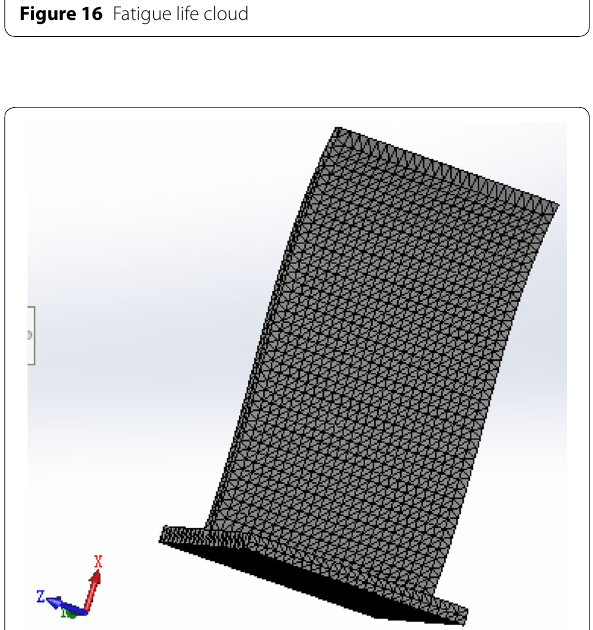
Figure 16 Fatigue life cloud